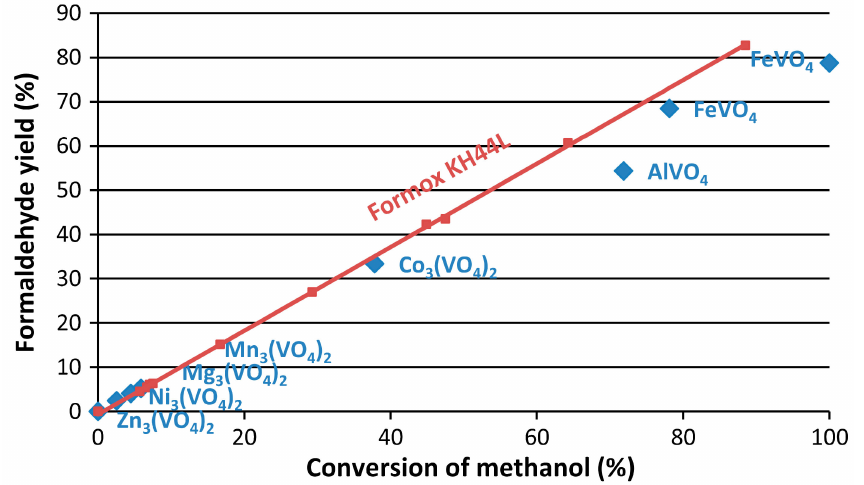
Figure 39. Comparison of catalytic performance of various vanadates to the Formox KH44L com- mercial catalyst shown as yield vs. conversion. T = 300 ◦ C. Feed: 6 vol.% MeOH and 11 vol.% O 2 in inert gas. Flow: 227–277 mL/min. Catalyst loading: 25–1000 mg catalyst (surface area of catalyst 0.1–3 m 2 ). Particle size: 0.215–0.425 mm. Reprinted with permission from [6] Springer, Topics in catalysis, Copyright ©